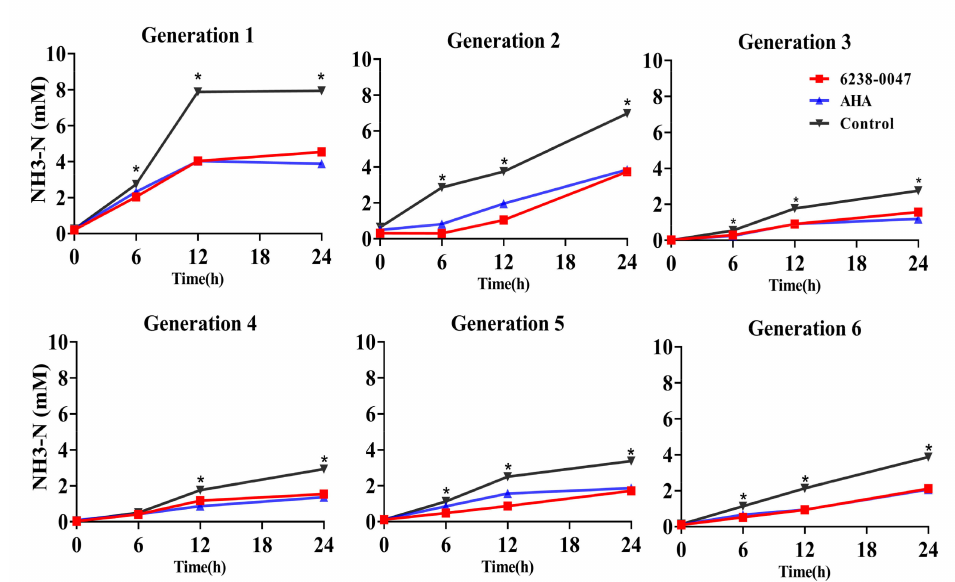
Figure 5. Influence of compound 6238-0047 and AHA on the amount of NH3-N production in rumen fermentation in vitro. Each point represents the mean of three observations. Acetohydroxamic acid (AHA) acted as a positive control, and the control group only added the solvent. Asterisks (*) indicate that the di ff erence between the control group and compound treated group (AHA and 6238-0047) was significant ( p < 0.01).